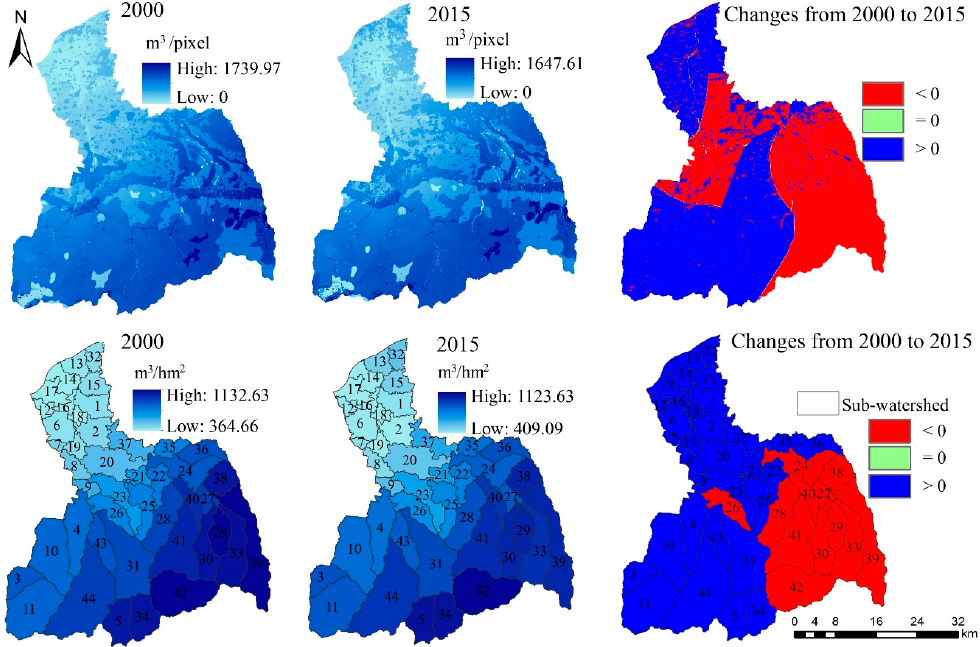
Figure 4. The spatial distribution and spatiotemporal changes of WY.